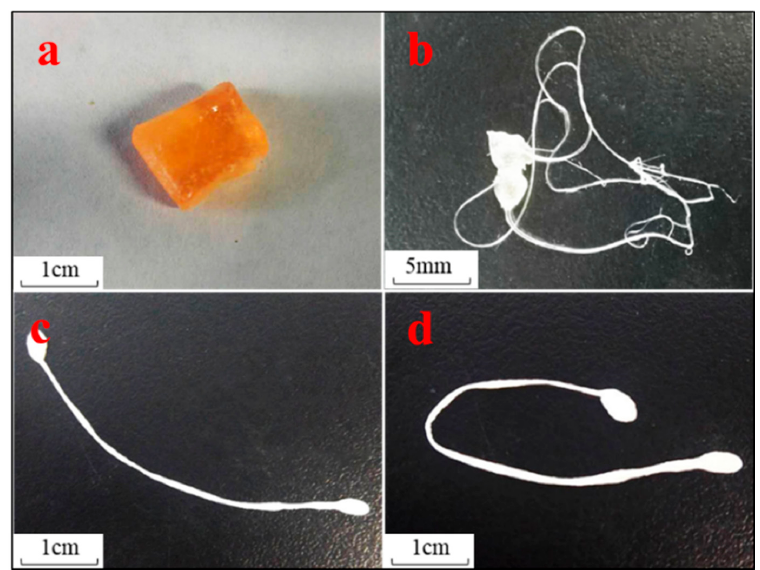
Figure 9. Transparent amorphous state solid of ABMP. ( a ) Appearance of amorphous state solid ABMP (ass-ABMP); ( b ) filiform appearance of ass-ABMP when an outside force was employed; ( c , d ) deformation is still possible after stretching several times.